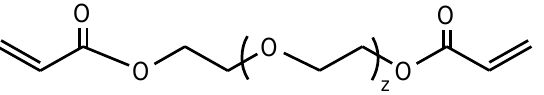
Figure 25. Poly(ethylene glycol) diacrylate coupler used to prepare hydrogels from unsaturated poly(ester amide)s.